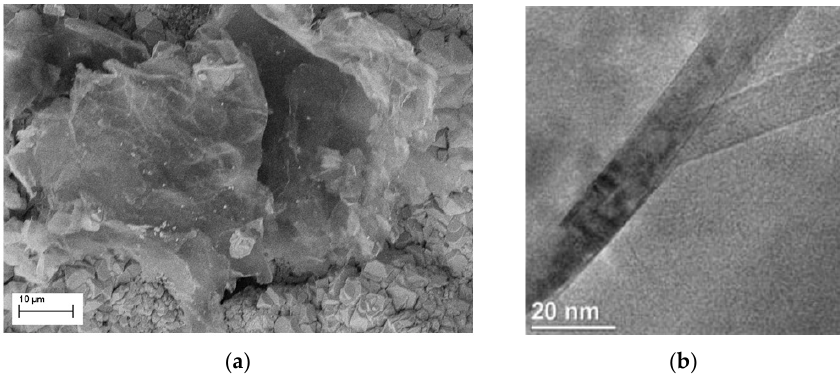
Figure 4. ( a ) SEM image of the disposition of a single GnP on the copper layer after the second